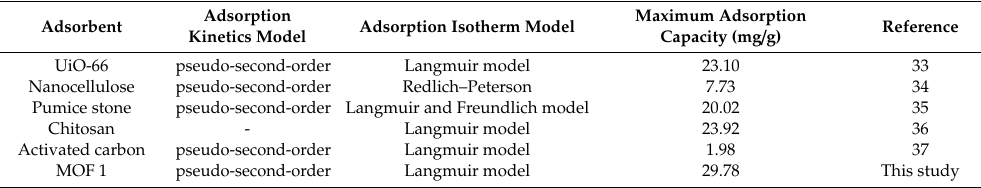
Table 3. Compare the adsorption process parameters of di ff erent absorbents to remove tetracycline from